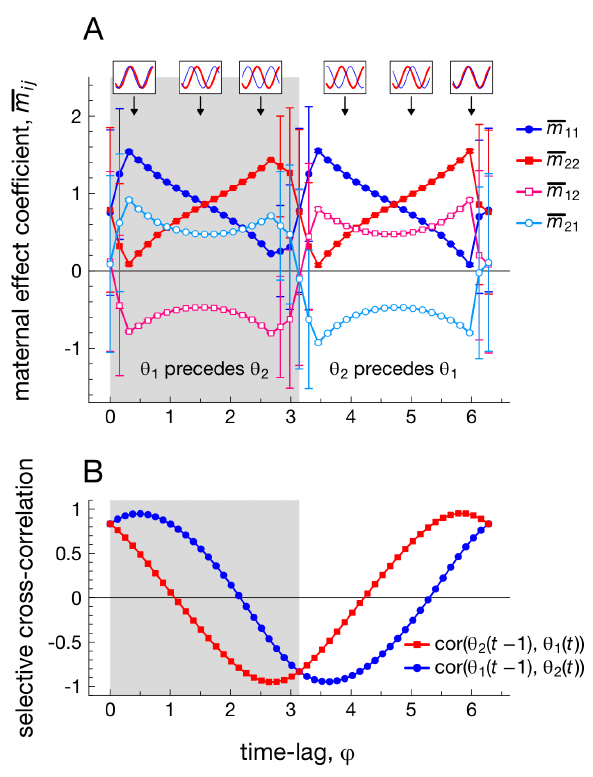
Figure 4. The evolution of multivariate maternal effects (panel A) when the evolutionary optimum h 2 ( t ) lags w timesteps behind the evolutionary optimum h 1 ( t ). Grey area: fluctuations in optimum h 1 ( t ) precede those of optimum h 2 ( t ) (0 v w v p ) . White area: h 2 ( t ) precedes h 1 ( t ) ( p v w v 2 p ) . Insets on the top of the panel depict the fluctuating selective optima h 1 ( t ) (blue line) and h 2 ( t ) (red line) over time. Panel B: selective cross-correlations that result from varying the time-lag between both selective optima. Note that each point in panel A depicts the maternal effect m ij (at generation t ~ 50000 ) averaged over ten replicate generations, while error bars depict corresponding standard deviations. Error bars are large when time lags are small, as evolution then leads to alternatively stable states observed in Figures 3A,B. The results in this figure also extend to a periodic environment in which the time delay w is stochastically distributed according to a normal distribution N ( (cid:2) ww , s 2 ) with mean (cid:2) ww [ f 0, ... ,2 p g w and variance s 2 varying from 0.1 to 4 (results not shown). w